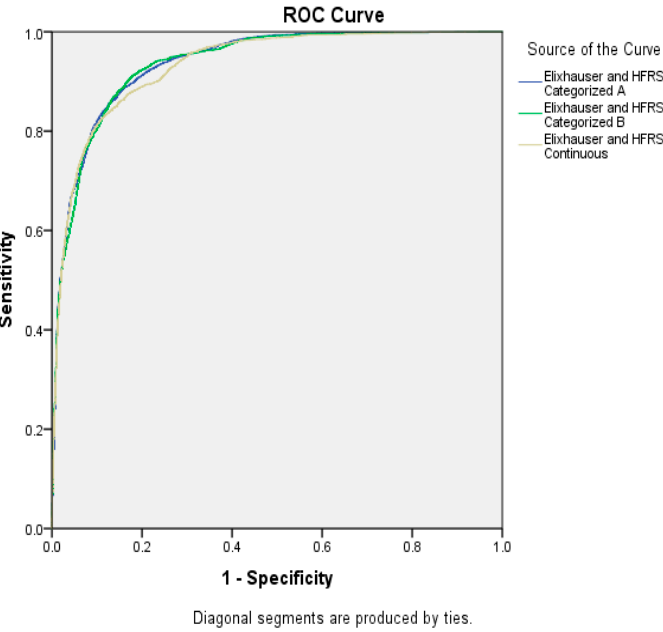
Figure 2. Area Under the Curve for the different parameters considered: including Elixhauser Comorbidity Index with HFRS to predict postoperative sepsis.